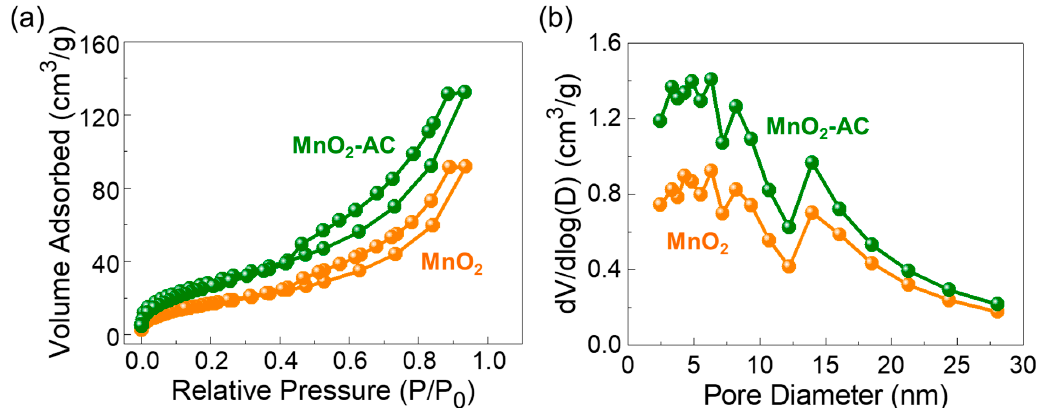
Figure 4. ( a ) Nitrogen adsorption–desorption isotherm characteristics and ( b ) Pore distribution